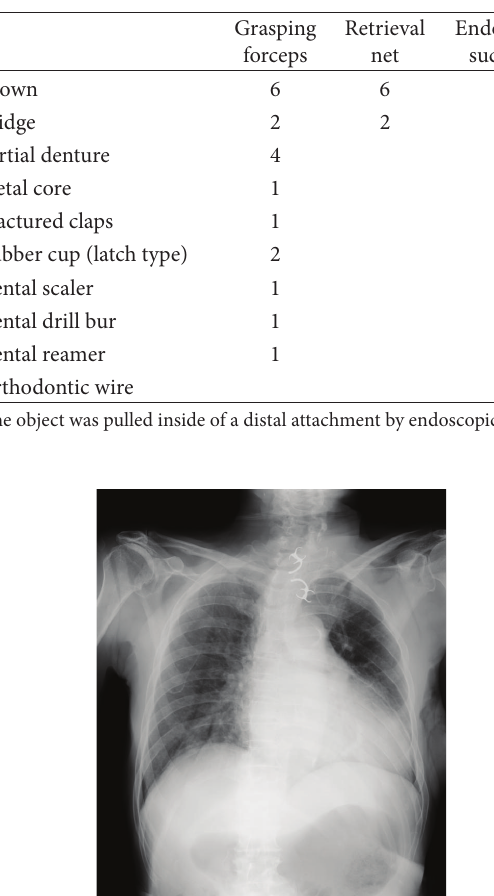
Table 4: Relationship between the type of ingested objects and the retrieval devices.